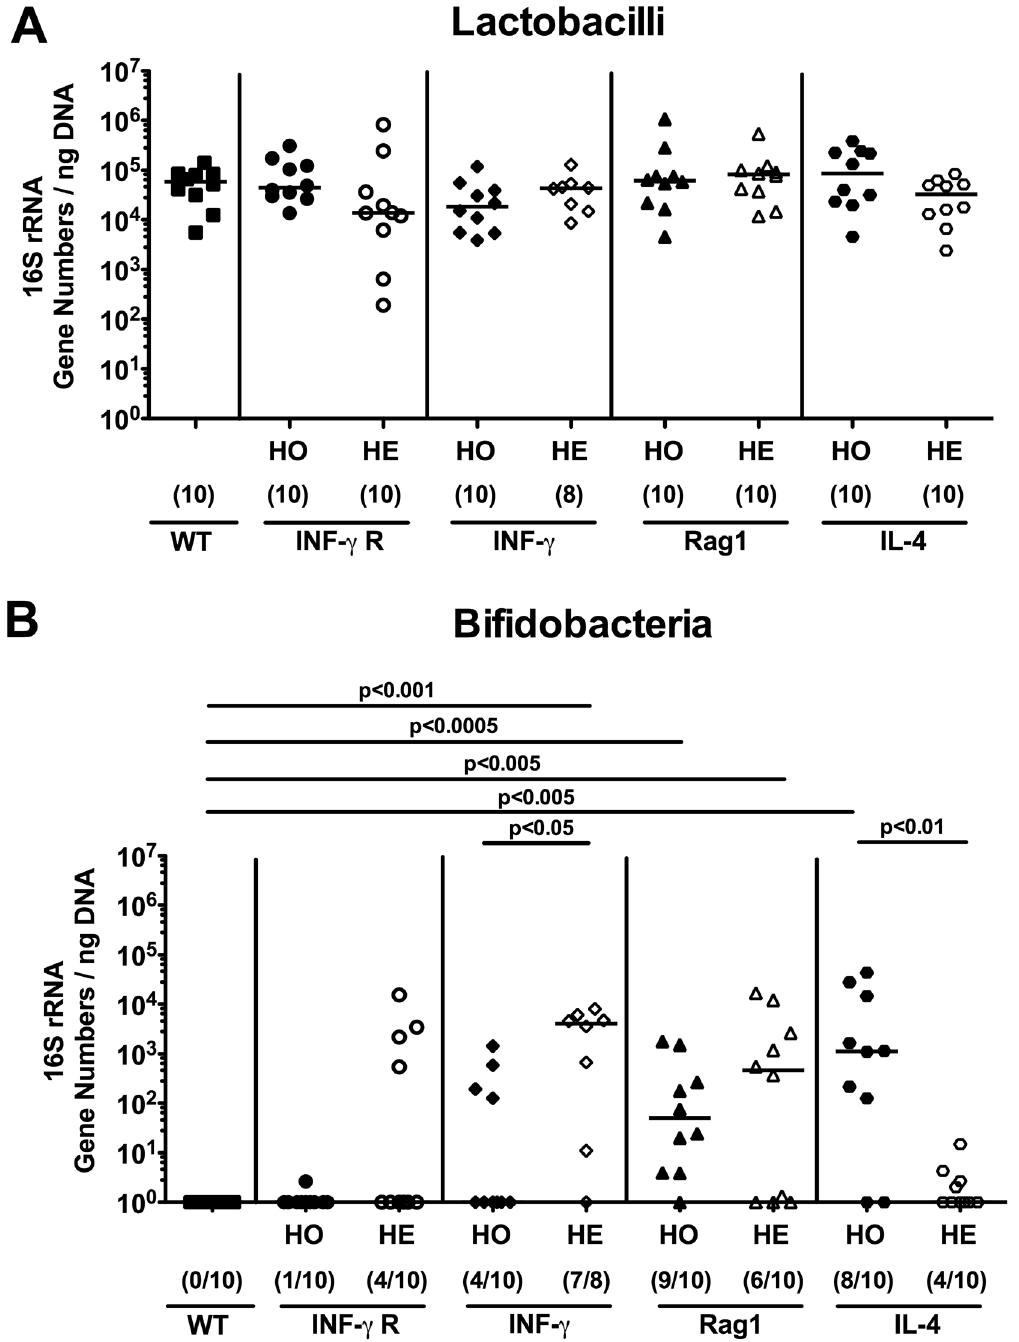
Figure 2. Commensal intestinal microbiota composition (lactobacilli and bifidobacteria) of mice kept under SPF conditions. After twelve weeks of housing under SPF conditions, 16S rRNA of main intestinal bacterial groups was quantified by qRT-PCR in fecal samples derived from homozygous (HO; filled symbols) and heterozygous (HE; open symbols) mice deficient for IFN- c Receptor (IFN- c R; circles), IFN- c (diamonds), Rag1 (triangle), or IL-4 (hexagons). Wildtype C57BL/6 (WT, black squares) served as controls. Quantitative abundance of ( A ) lactobacilli and ( B ) bifidobacteria are expressed in gene numbers per ng DNA. Medians (black bars), levels of significance ( P -values) determined by the Mann-Whitney-U test and numbers of analyzed animals (in parentheses) are indicated. doi:10.1371/journal.pone.0113406.g002 0.01; Fig. 7E ), whereas loads of either Clostridium group were Clostridium leptum 16S rRNA levels were slightly higher (mean slightly higher (0.6–1.4 order of magnitude mean difference) in difference 0.75 orders of magnitude) in IVC housed Rag1 + / 2 (HE) Rag1 2 / 2 (HO), but not in Rag1 + / 2 (HE) mice when kept in open as compared to IVC Rag1 2 / 2 (HO) mice (p , 0.05; Fig. 7G ). The as compared to IVC cages (p , 0.05; Fig. 7G, H ). Furthermore, amount of the remaining bacterial groups did not differ between